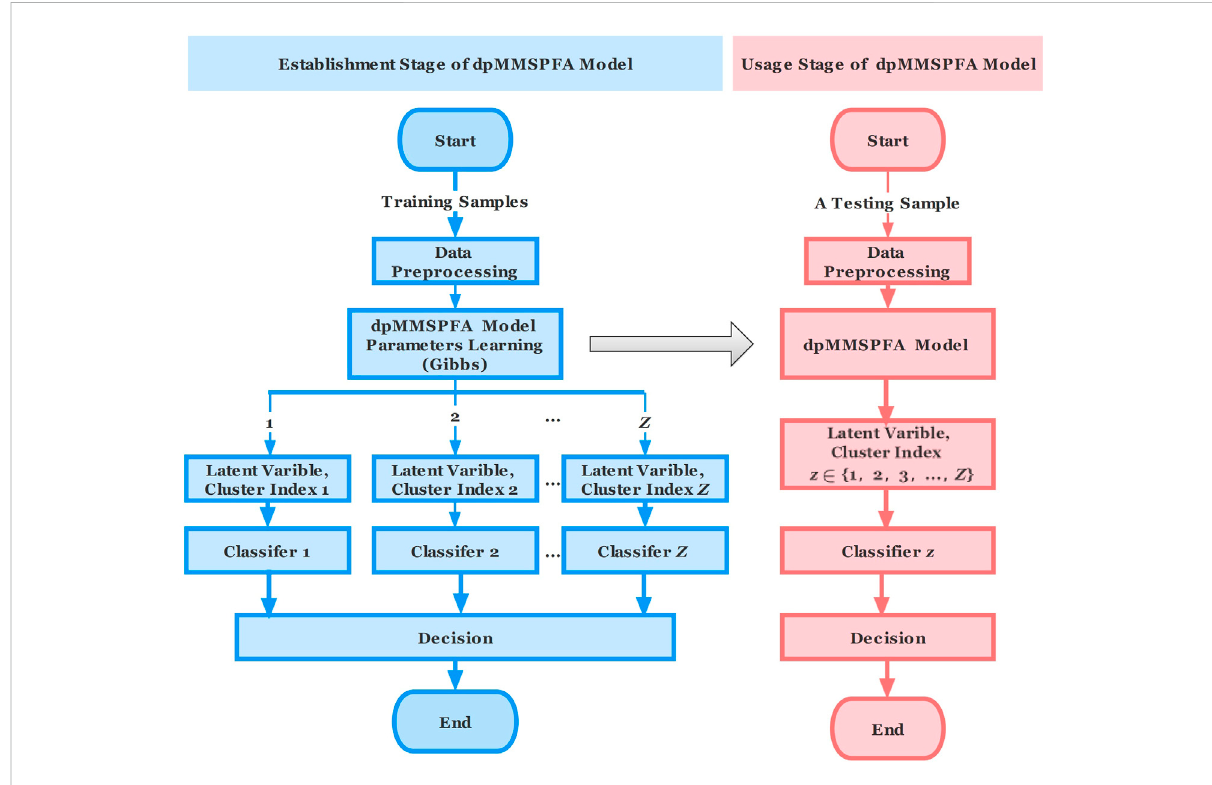
FIGURE 2 The classi fi cation system frame for dpMMSPFA.